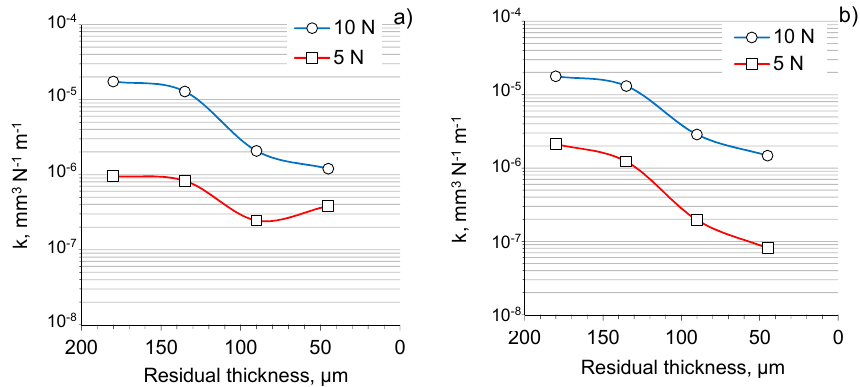
Figure 9. Wear coefficients ( k ) for coatings on THE Al 2024 alloy with different residual thicknesses derived from the results of the LRSW tests against ( a ) WC-4%Co and ( b ) bearing steel counterfaces at 5 and 10 N loads. The figure represents the averaged results, with the error bars being smaller than the size of data points.